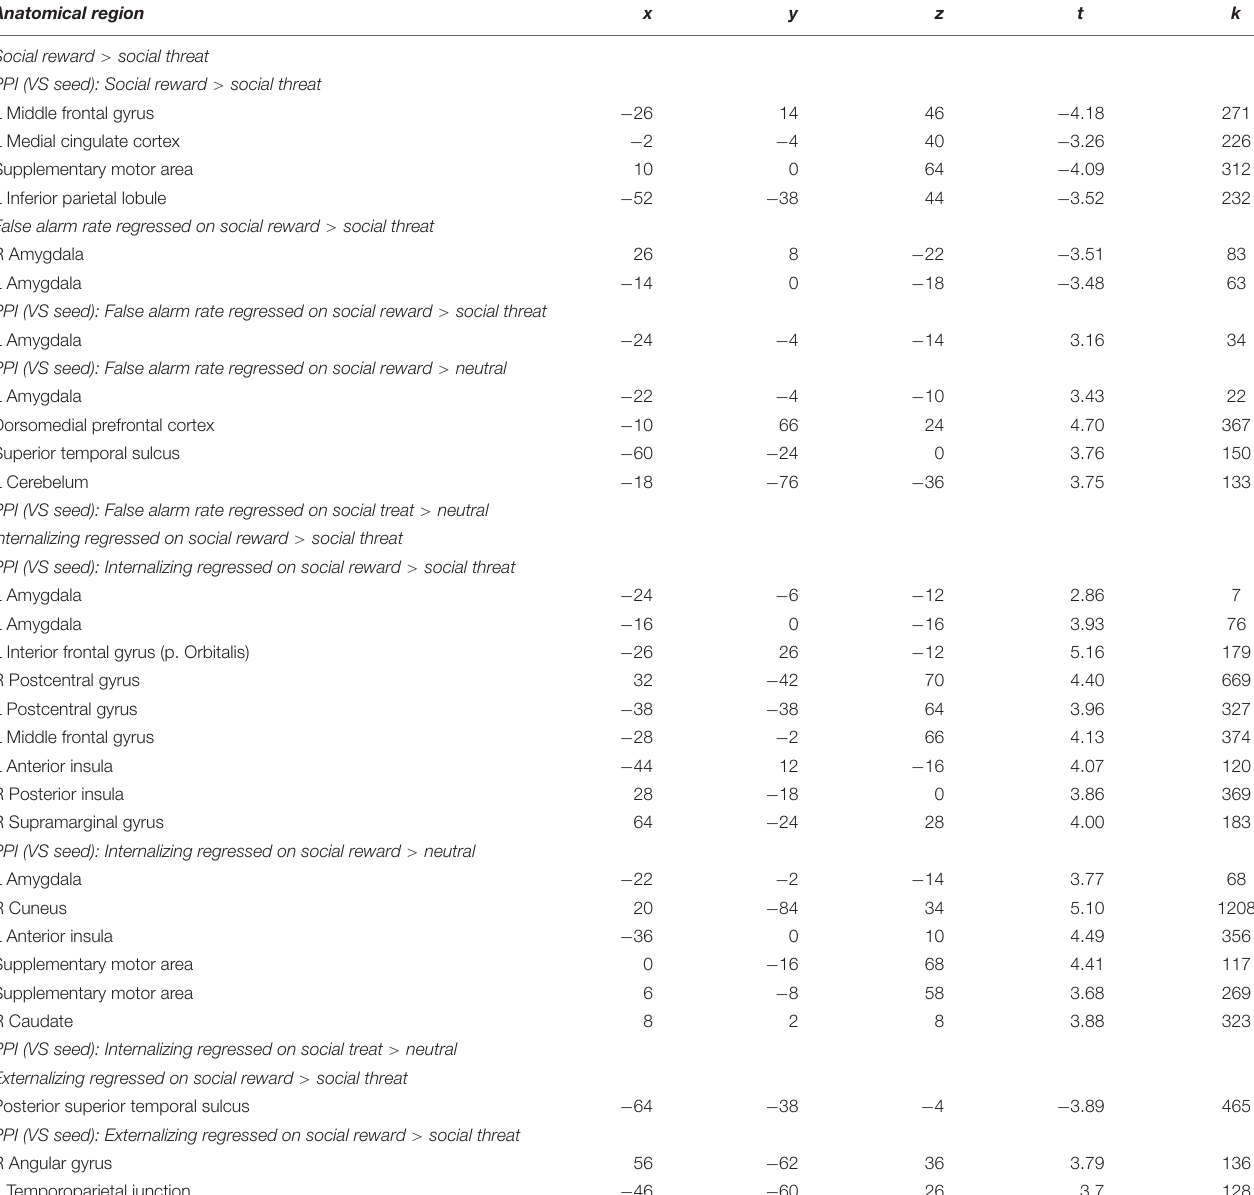
TABLE 1 | Brain activation patterns for neural activation and functional connectivity. Anatomical